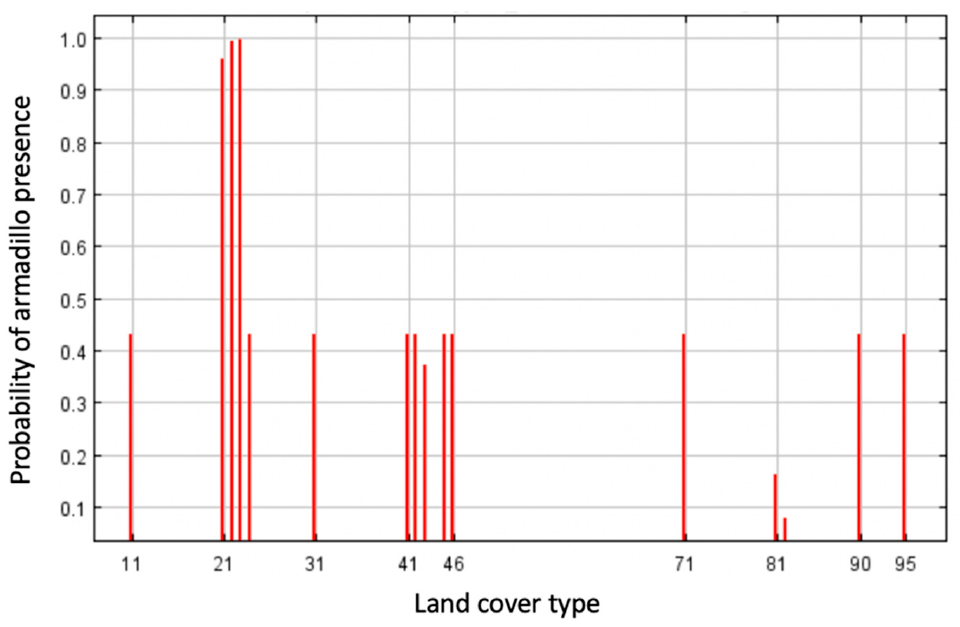
Figure 4. Response curve for land cover type as an environmental predictor for presence of nine- banded armadillo in southern Illinois during 2016–2020. Land cover groups are represented as fol- lows: open water (11), open space development (21), low development (22), medium development (23), high development (24), barren land (31), deciduous forest (41), evergreen forest (42), mixed forest (43), herbaceous (71), hay/pasture (81), cultivated crops (82), woody wetlands (90), and emer- gent herbaceous wetlands (95). Probability of armadillo presence was highest in open space to me- dium development, and lowest in agricultural cover.